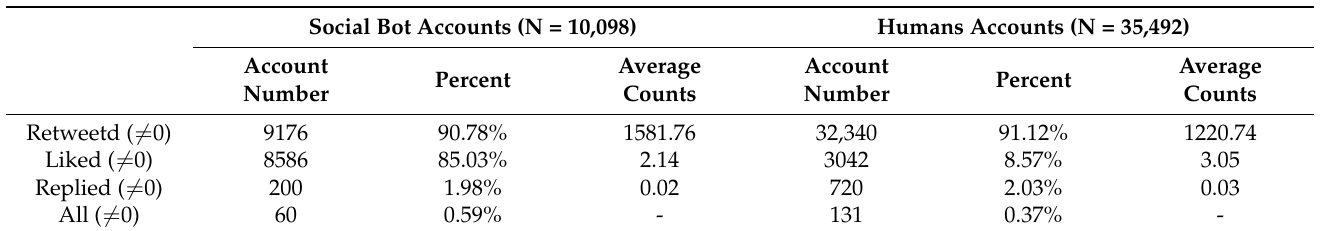
Table 2. Influence of social bot and human tweet accounts based on retweeted, liked, and replied. Social Bot Accounts (N = 10,098) Humans Accounts (N = 35,492)